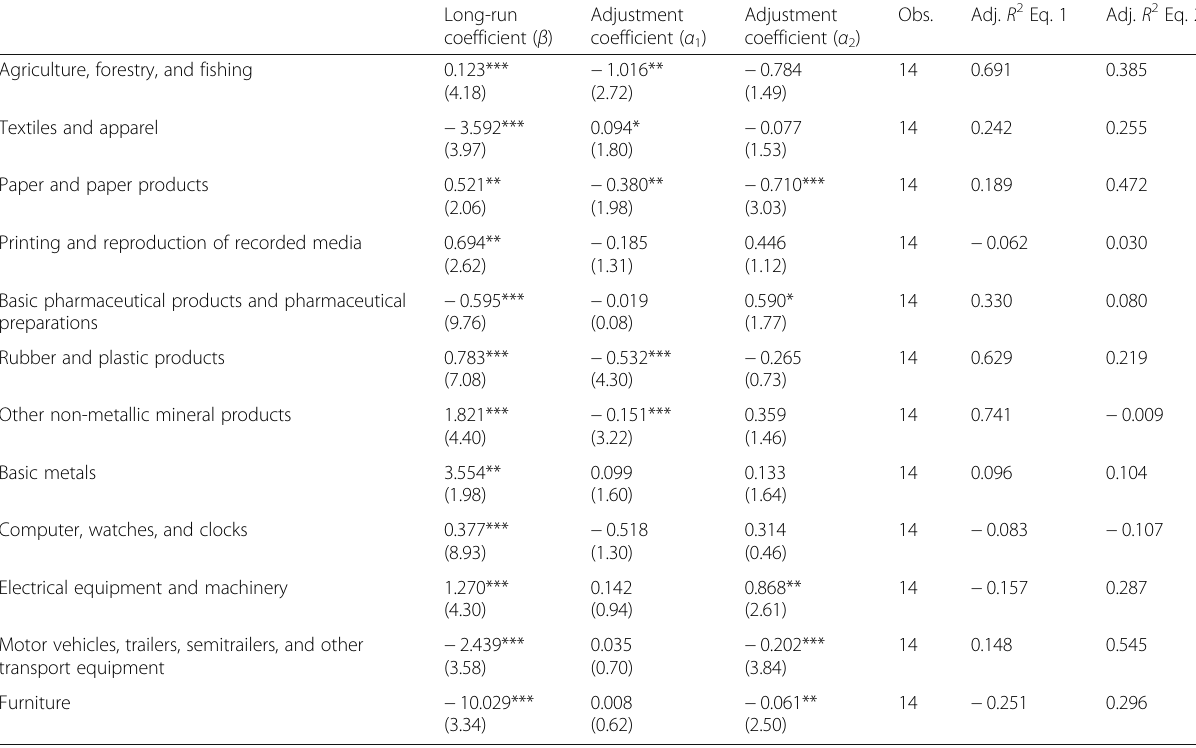
Table 3 Relationship between exports and productivity for selected sectors